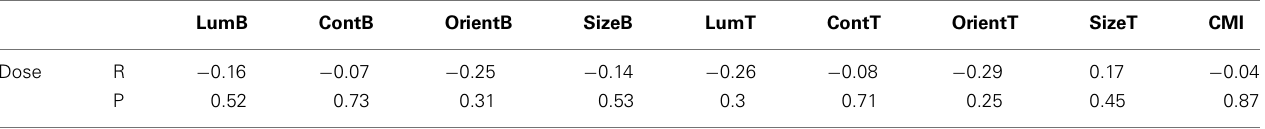
Table 5 | Correlations between medication dose (chlorpromazine equivalent in mg/day) and individual behavioral measures (biases and